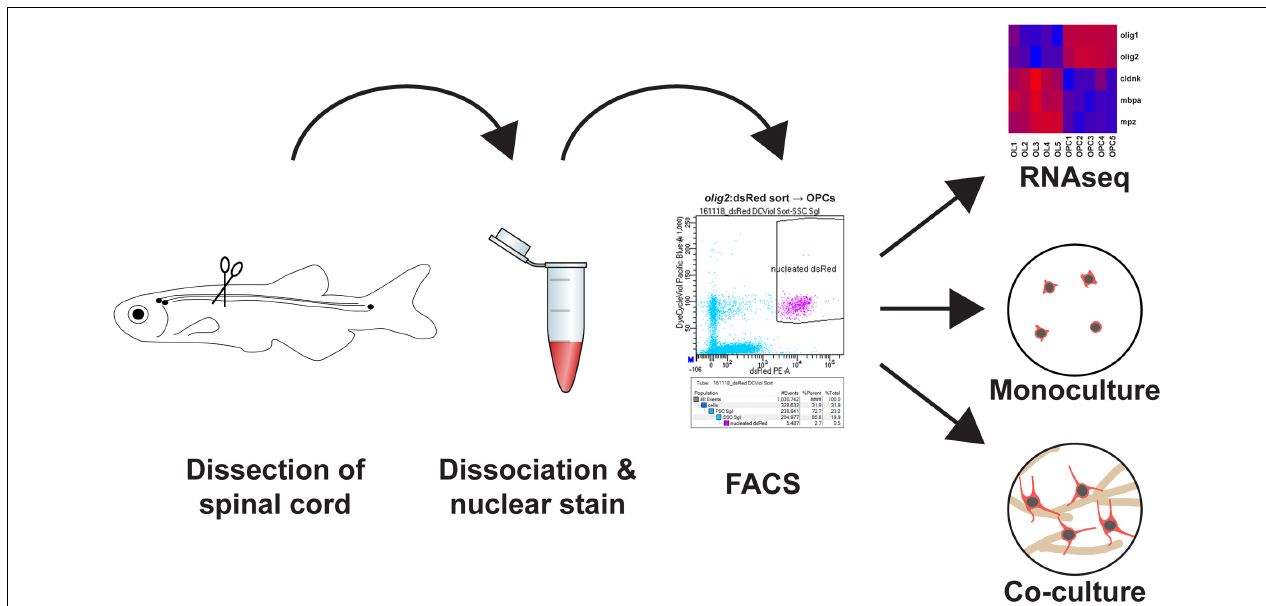
FIGURE 1 | Main steps to obtain a highly pure adult zebrafish spinal oligodendrocyte progenitor cell (OPC) population: (1) Adult zebrafish spinal cord tissue is dissected. (2) The tissue is first dissociated by enzymatic digestion and then incubated with a nuclear dye. (3) The cell suspension is FACsorted based on cytoplasmic and nuclear fluorescence. (4) The purified OPCs can then be used directly for transcriptome analysis, cell culture as monoculture to study dormant OPCs or in motor neuron/OPC co-cultures to study oligodendrocyte differentiation.